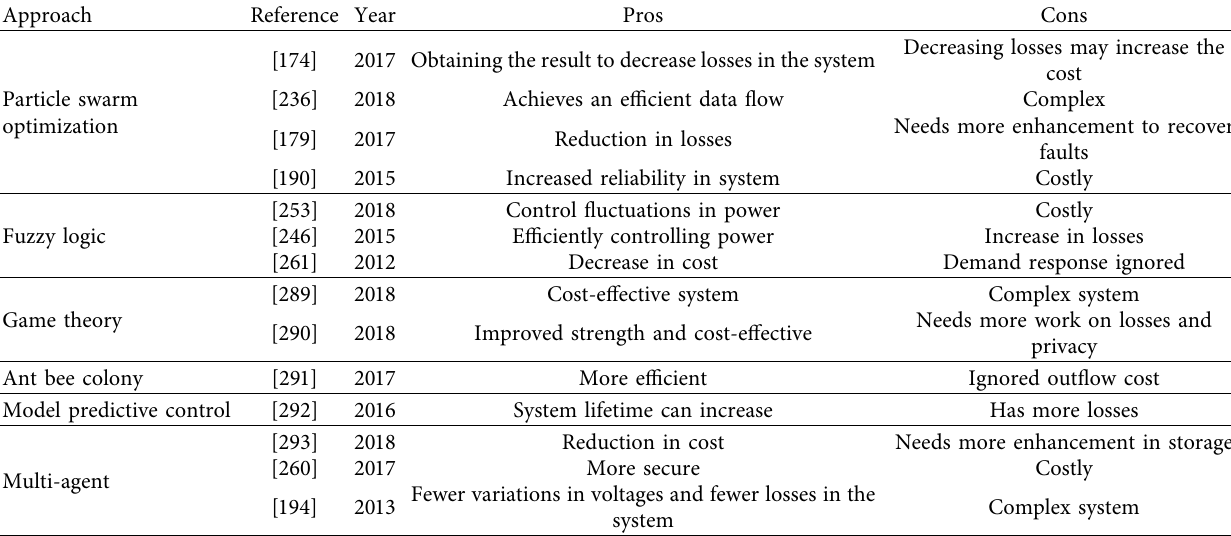
Table 9: Enhanced approaches to the energy management system.